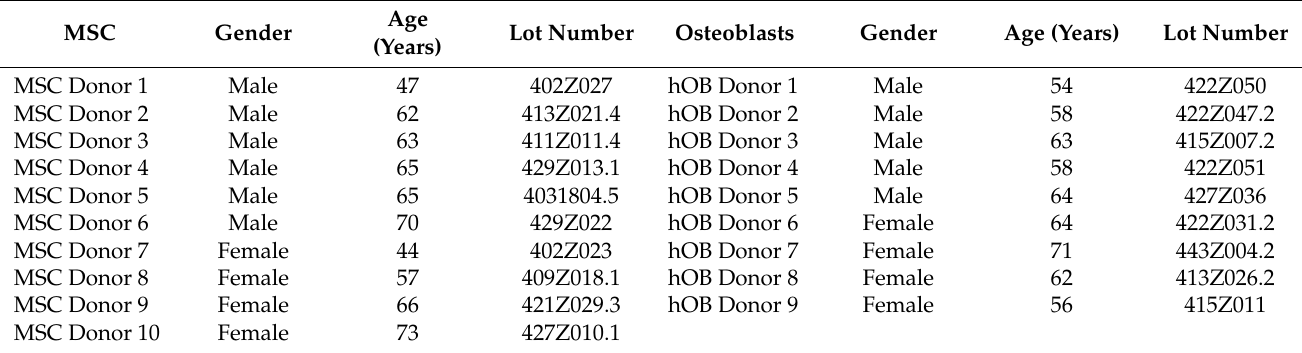
Table 1. The characteristics of the MSC and osteoblast donors.